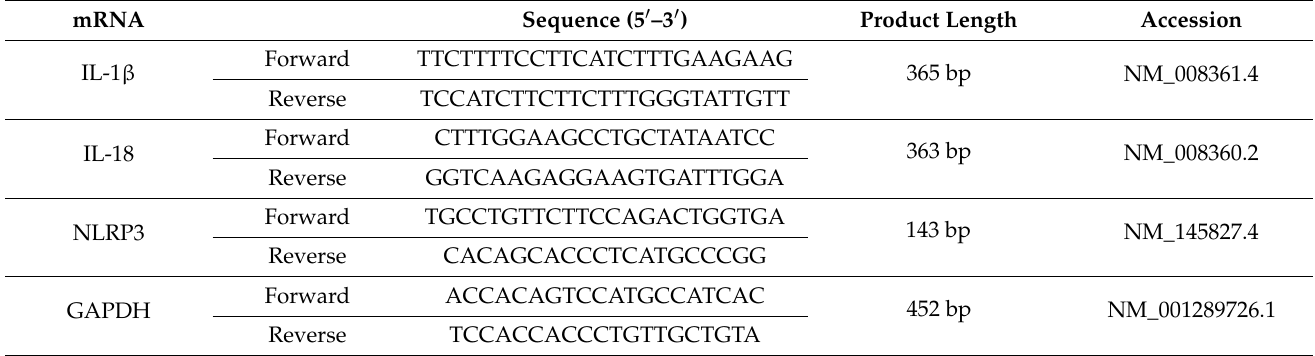
Table 2. PCR primer